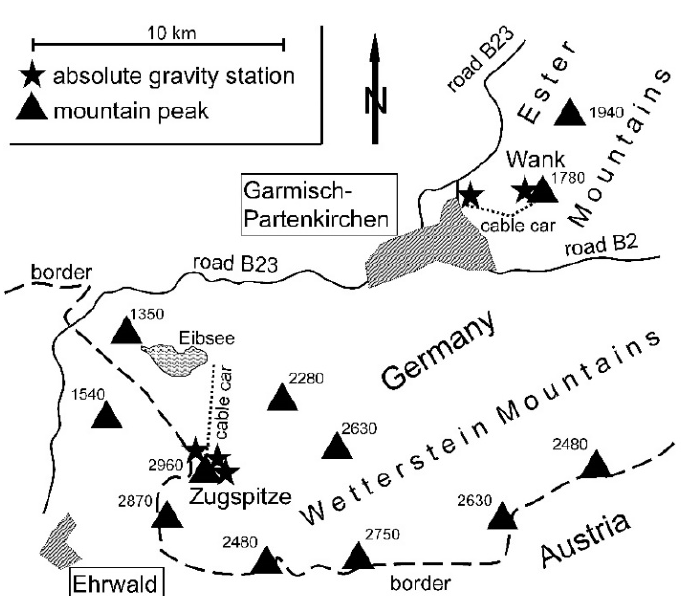
Figure 1. Map (re-drawn from [32]) with the absolute gravity sites (stars) at the top of Mt. Zugspitze and at Mt. Wank foot and summit. Figures are heights of mountain peaks.